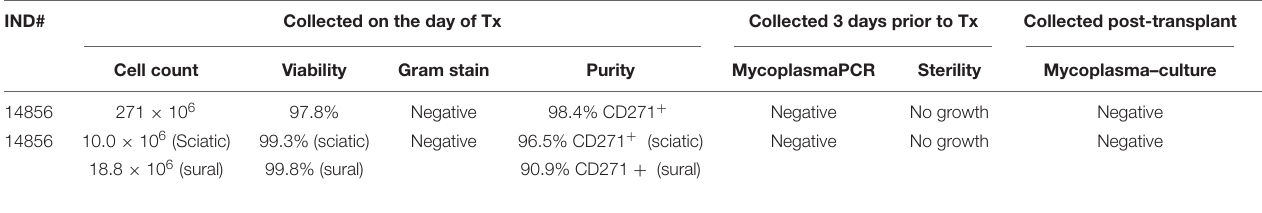
TABLE 4 | Release criteria analysis of final SC